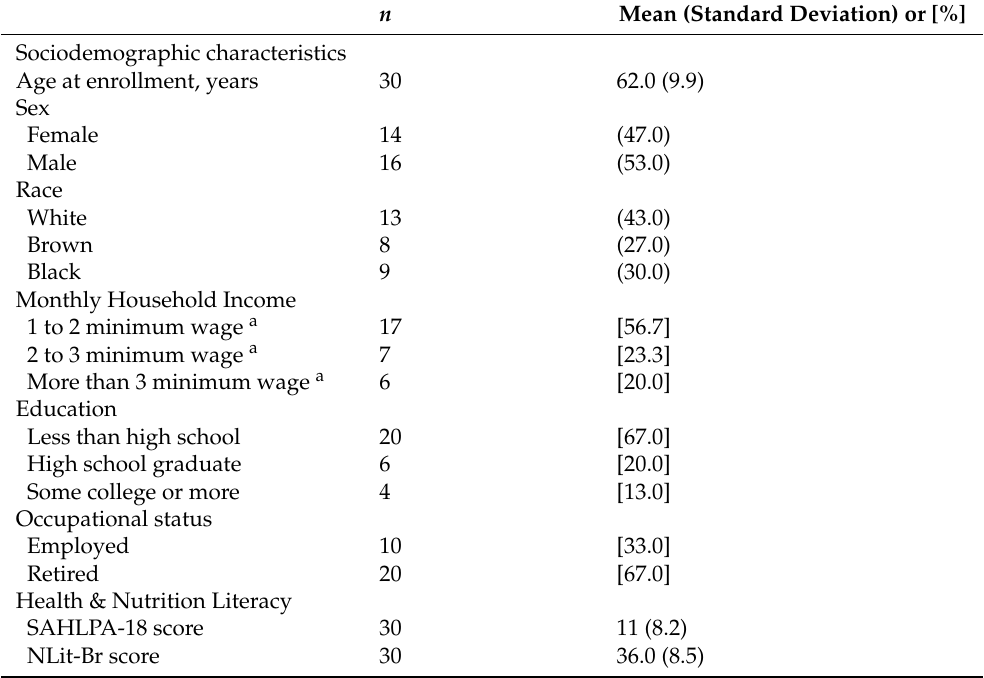
Table 1. Sociodemographic, health literacy and nutrition literacy data for Brazilians ( n = 30). n Mean (Standard Deviation) or